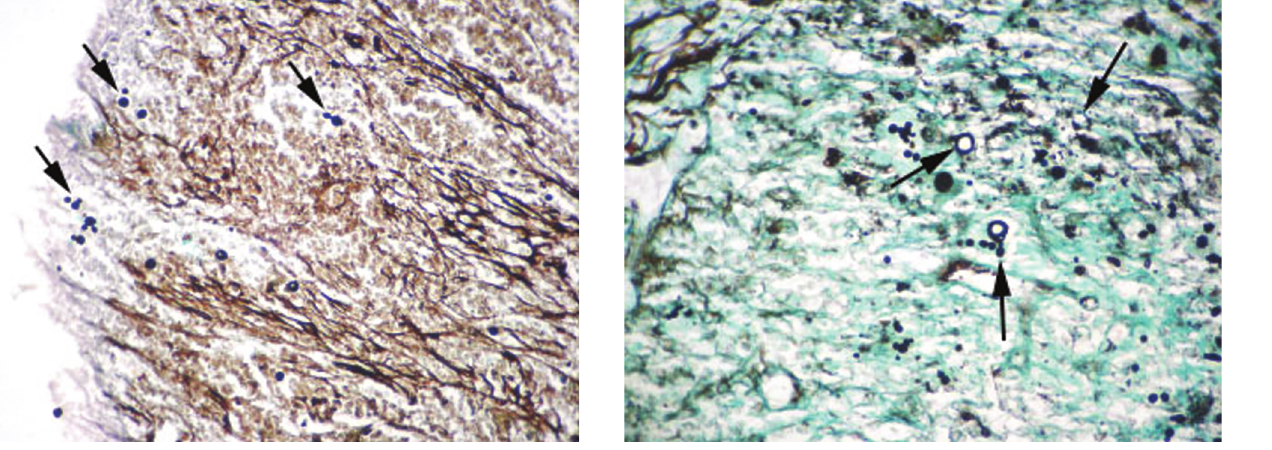
Figure 6 – Gomori-Grocott-stained preparations showing the fungal cells (arrows), confirming the diagnosis of prostatic PCM; 400X, zoom